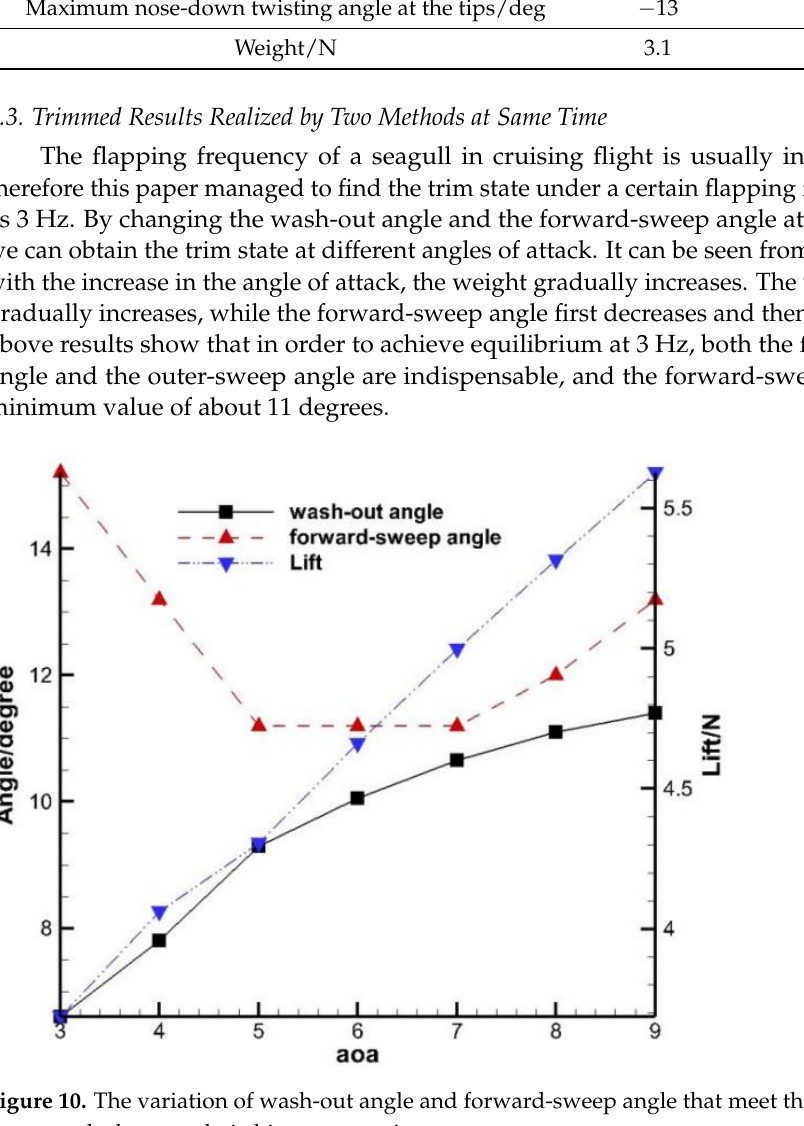
Table 5. Characteristics of longitudinal stability at three angles of attack. AoA/Deg